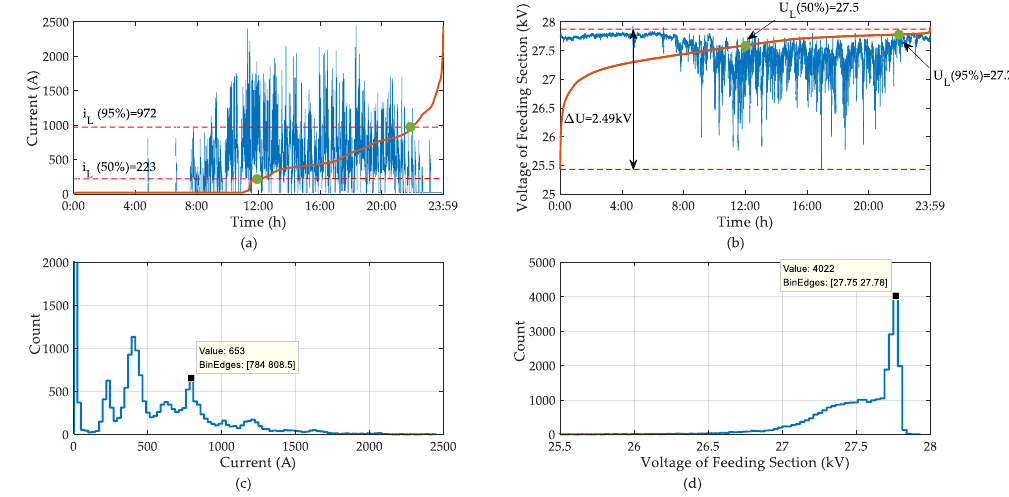
Figure 7. The measurements and statistical results of the α feeding section. ( a ) The current variation during a day; ( b ) the voltage variation during a day; ( c ) the histogram of current in ( a ); ( d ) the histogram of voltage in ( b ).